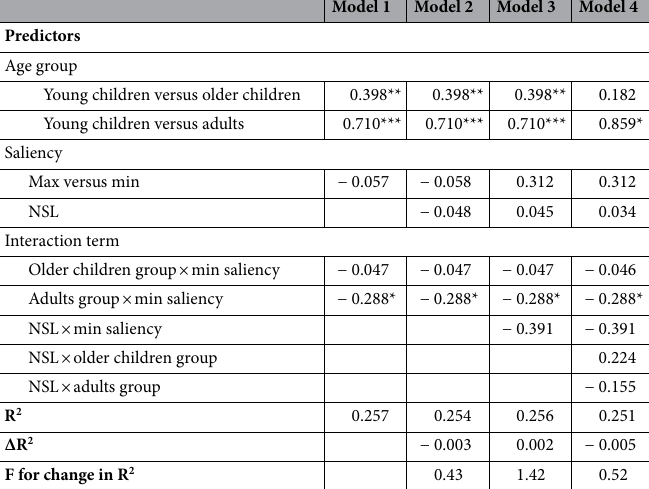
Table 3. Summary of hierarchical regression analyses for variables predicting ‘Correct & Sure’ responses. Standardized regression coefficients (β) are reported for each predictor. The age group was presented as three dummy variables (young children, older children, and adults) with young children serving as the reference group. The saliency condition was presented as two dummy variables (Max and Min) with Max saliency serving as reference condition. * p < .05, ** p < .01, *** p <